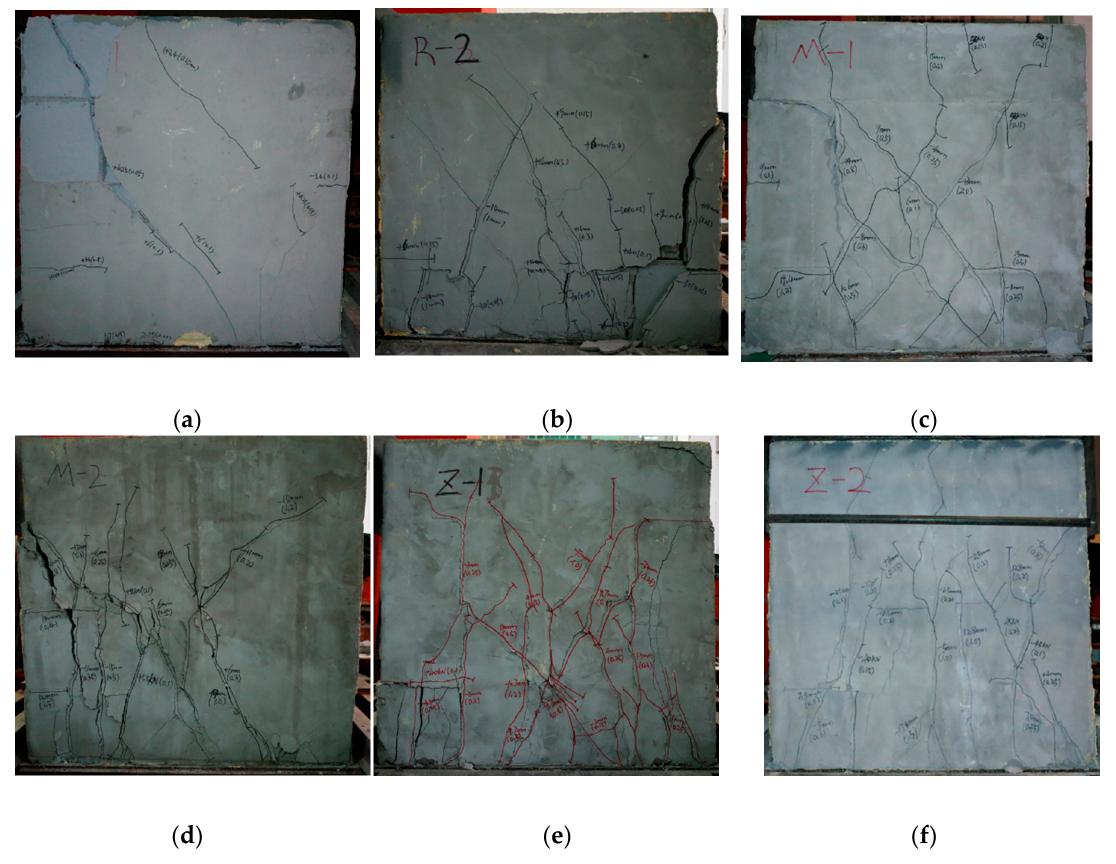
Figure 4. Failure modes of walls: ( a ) R-1; ( b ) R-2; ( c ) M-1; ( d ) M-2; ( e ) Z-1; ( f ) Z-2.